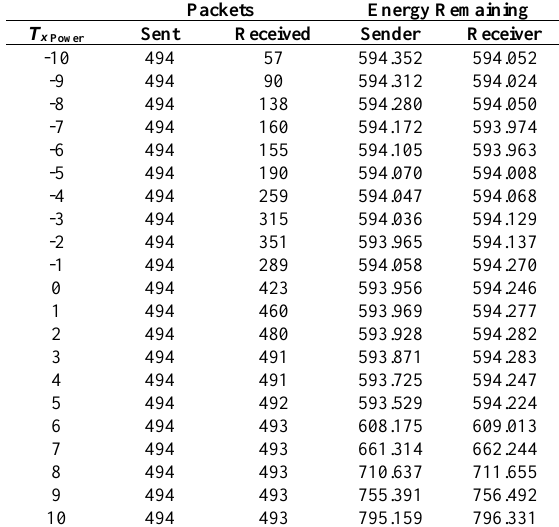
Table 11. Summary of the results under Scenario 1c